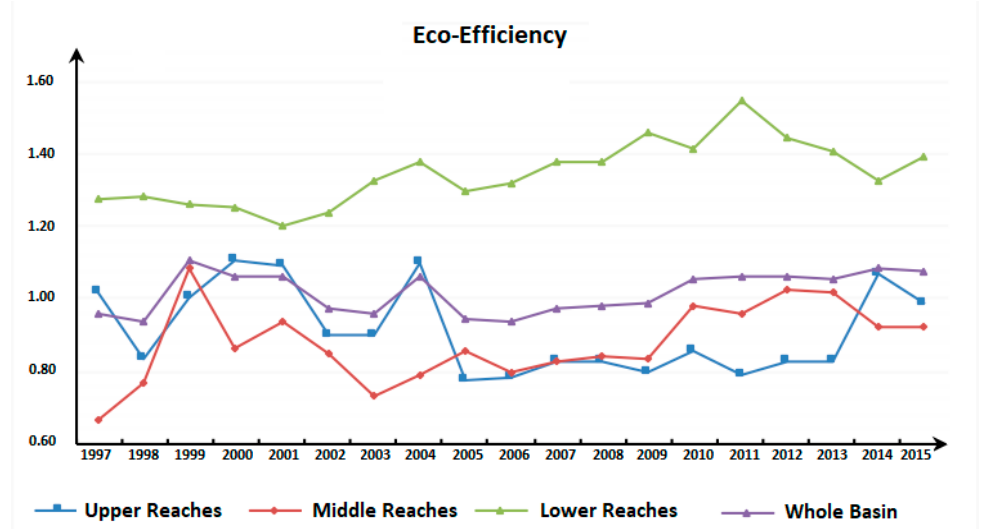
Figure 5. 1997–2015 Evolution Trend of the Eco-efficiency of Industrial Energy in the Yangtze River Economic Belt.